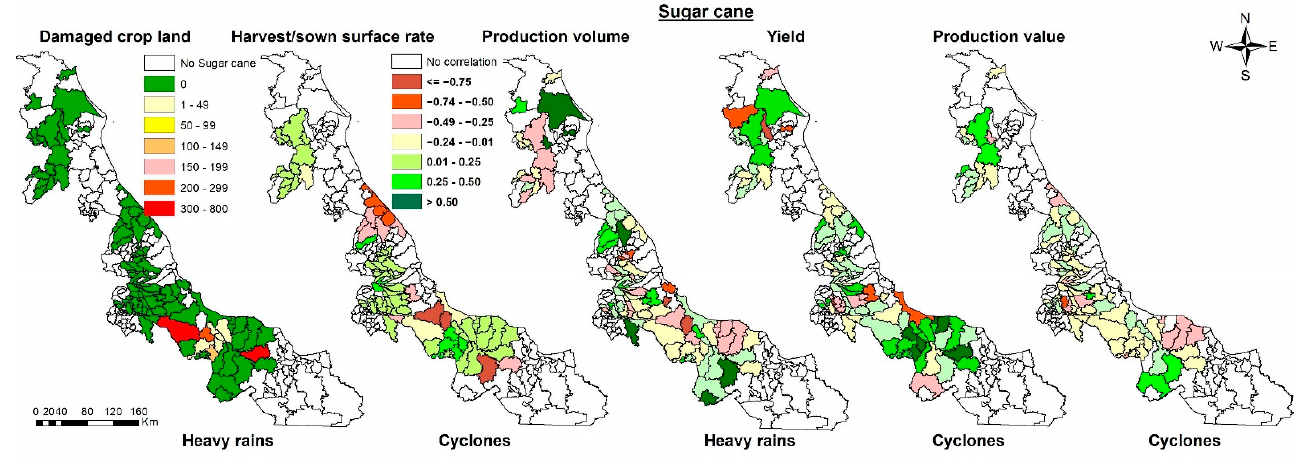
Figure 8. Sugar cane damaged cropland and production values correlated with disaster declarations in the municipalities of the State of Veracruz from 2003 to 2020. No sugar cane: entities with no sugar cane crops. No correlation: sites with no correlation with the phenomena. Source: projections based on data from the Mexican National Center to Prevent Disasters statistics [15] and the Mexican National Agrifood System [5].